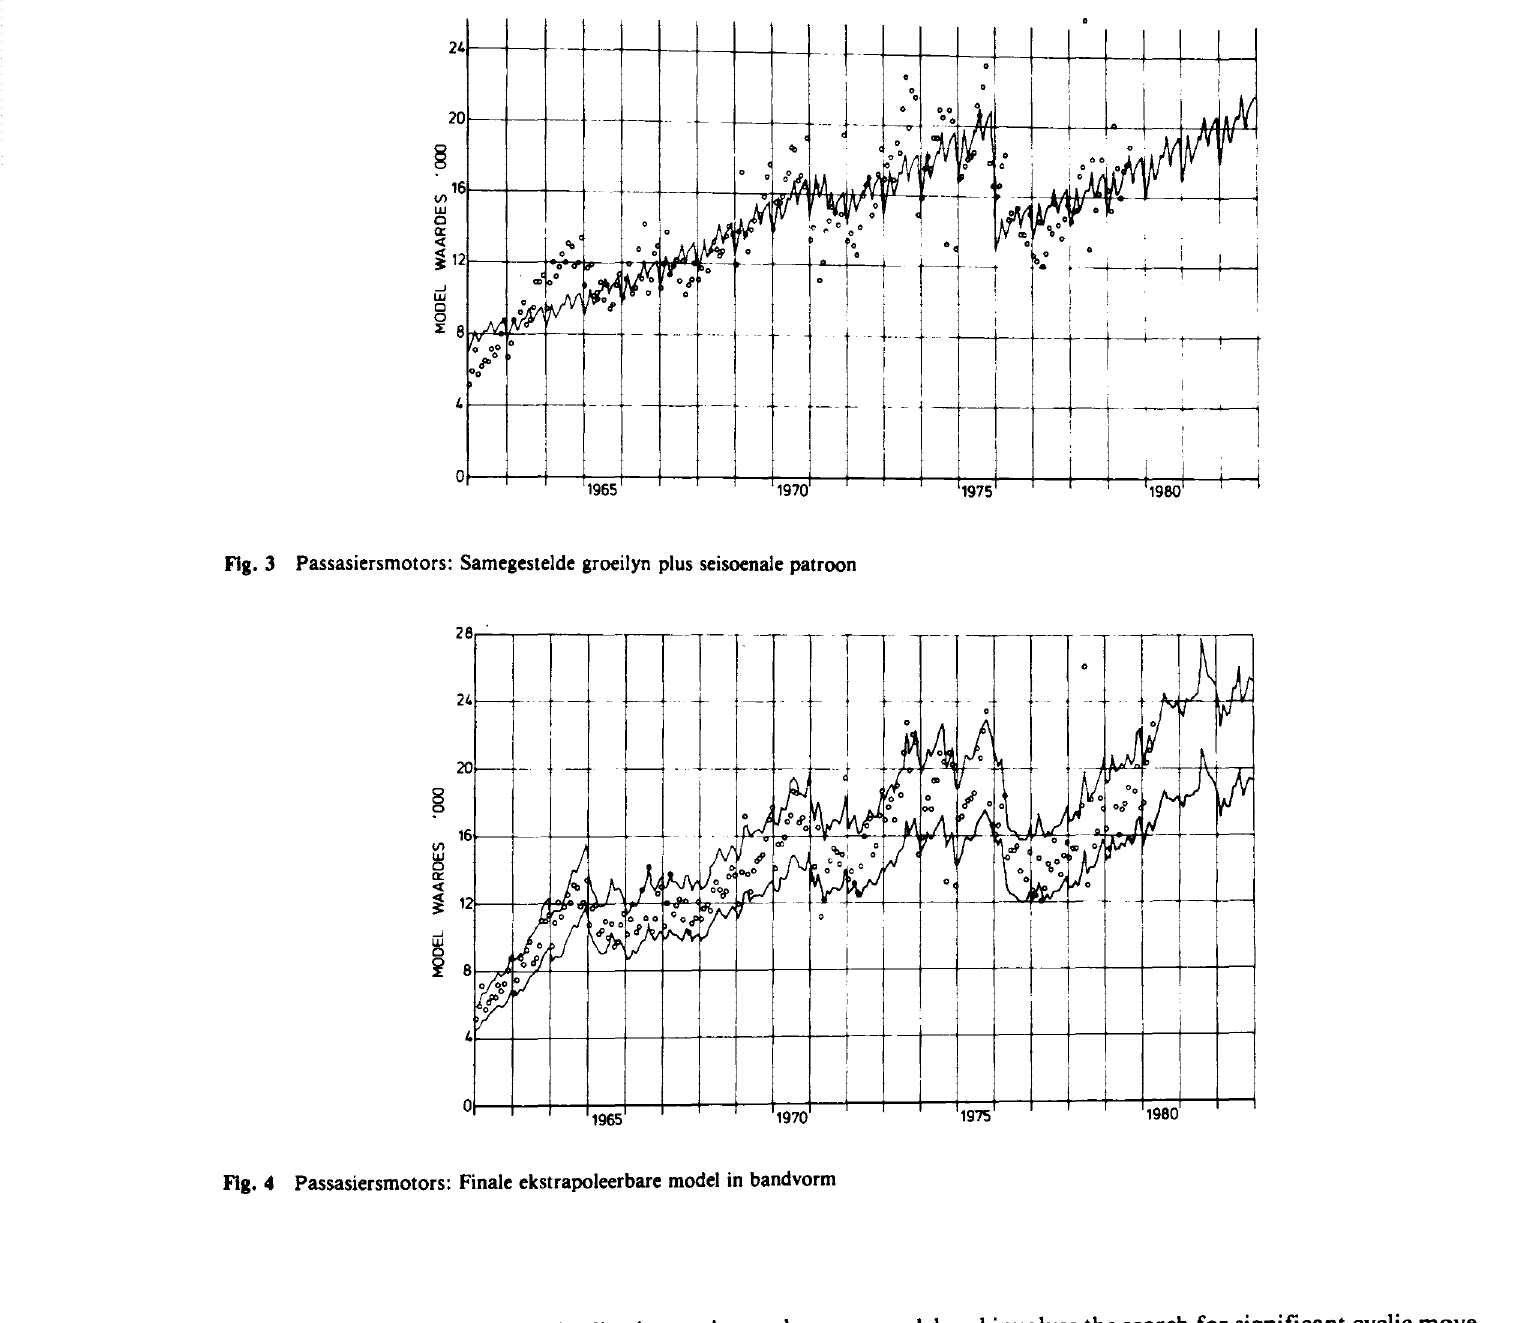
Fig. 4 Passasiersmotors: Finale ekstrapoleerbare model in bandvorm